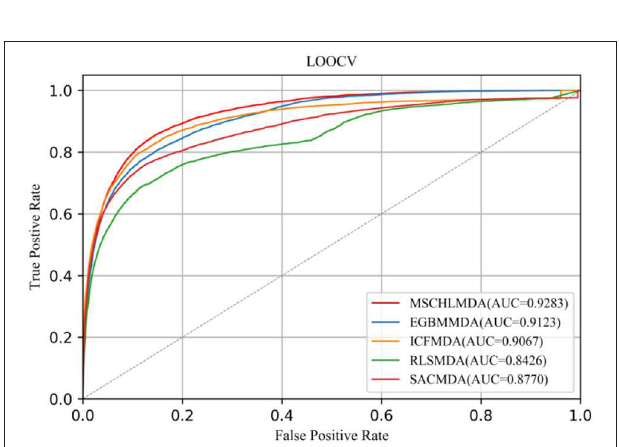
FIGURE 4 | The effect of varying the parameters on the MSCHLMDA performance.